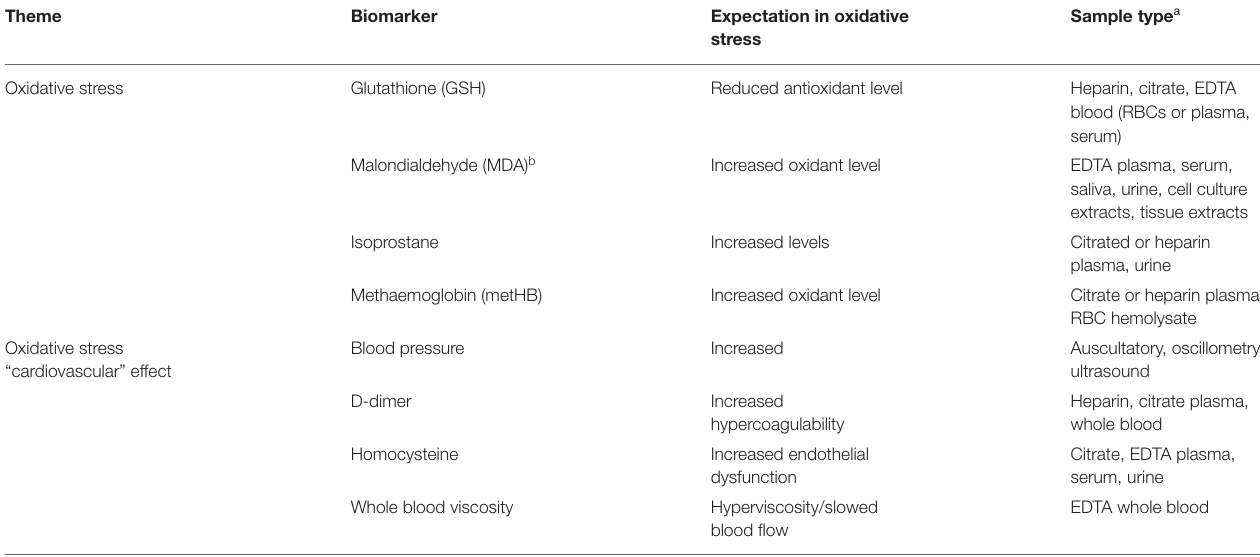
TABLE 1 | Oxidative damage panel useable in the laboratory as oxidative stress